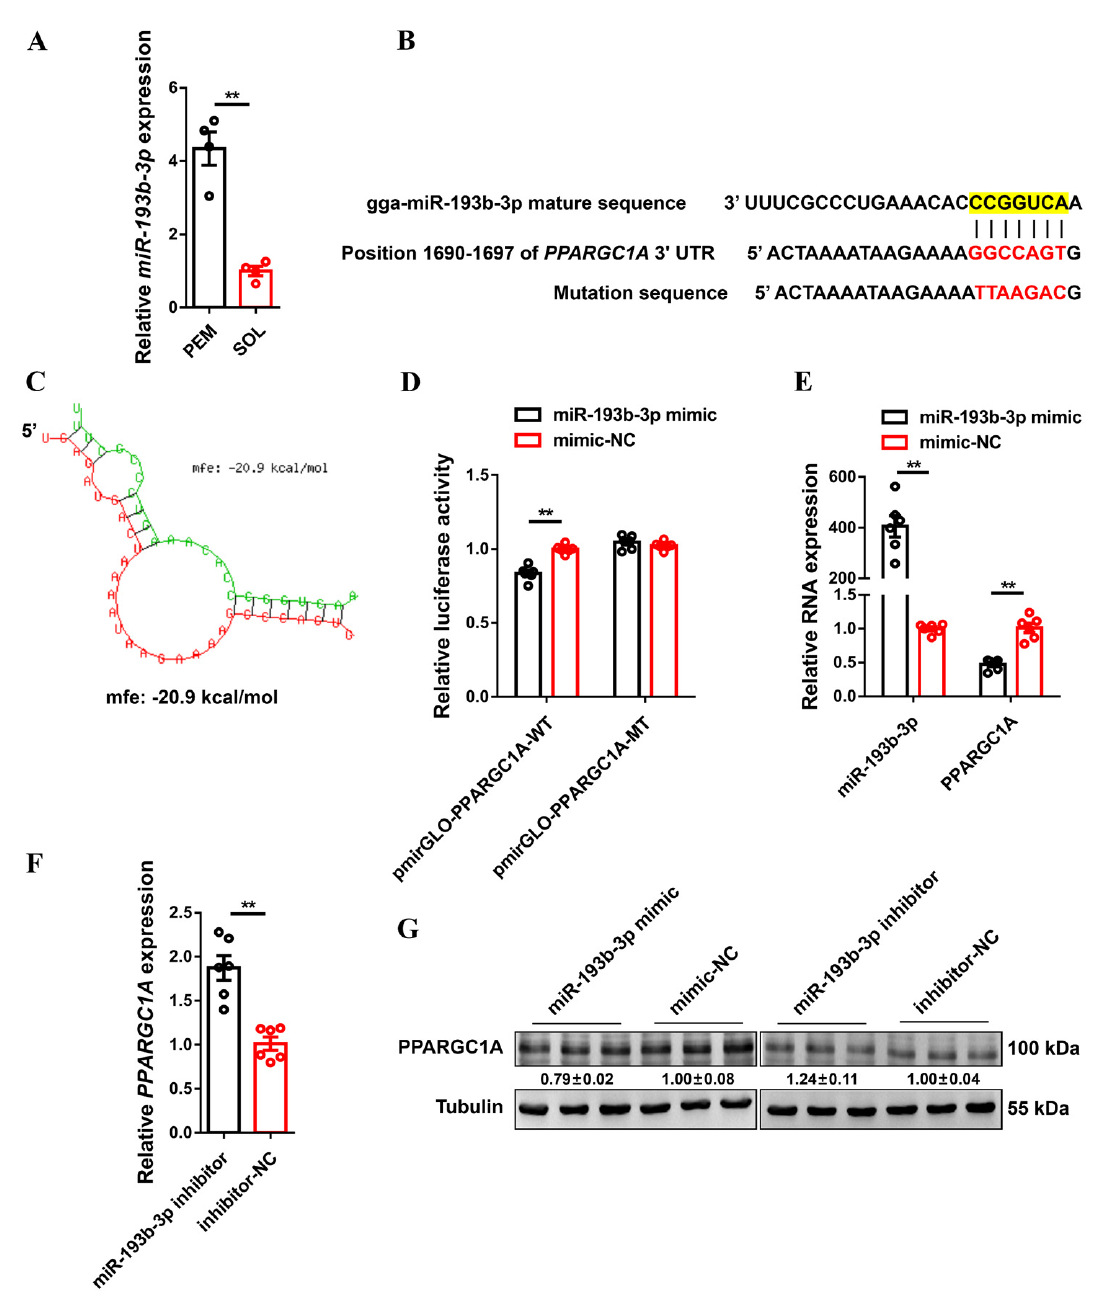
Figure 6. Identification of PPARGC1A as a direct target of miR-193b-3p . ( A ), relative miR-193b-3p expression in pectoralis major (PEM) and soleus (SOL) of 7-week-old Xinghua chicken detected by RNA-seq. ( B ), the potential binding site of miR-193b-3p in PPARGC1A 3 ′ untranslated region (UTR). The mutant sequence in miR-193b-3p binding site is highlighted in red. ( C ), the potential interaction model between miR-193b-3p and PPARGC1A from RNAhybrid. ( D ), luciferase assay was conducted by co-transfecting wild-type or mutant PPARGC1A 3 ′ UTR with miR-193b-3p mimic or mimic-negative control (NC). ( E ), relative miR-193b-3p and PPARGC1A expression after miR-193b-3p overexpression. ( F ), relative PPARGC1A expression after miR-193b-3p inhibition. ( G ), the protein expression level of PPARGC1A with miR-193b-3p overexpression or inhibition. In panel ( G ), ImageJ was used to measure band intensities. The fold change relative to the control is shown below the bands. In panels ( A , D – F ), results are presented as mean ± SEM, and paired t –tests were used to assess the statistical significance of differences between means. (** p <